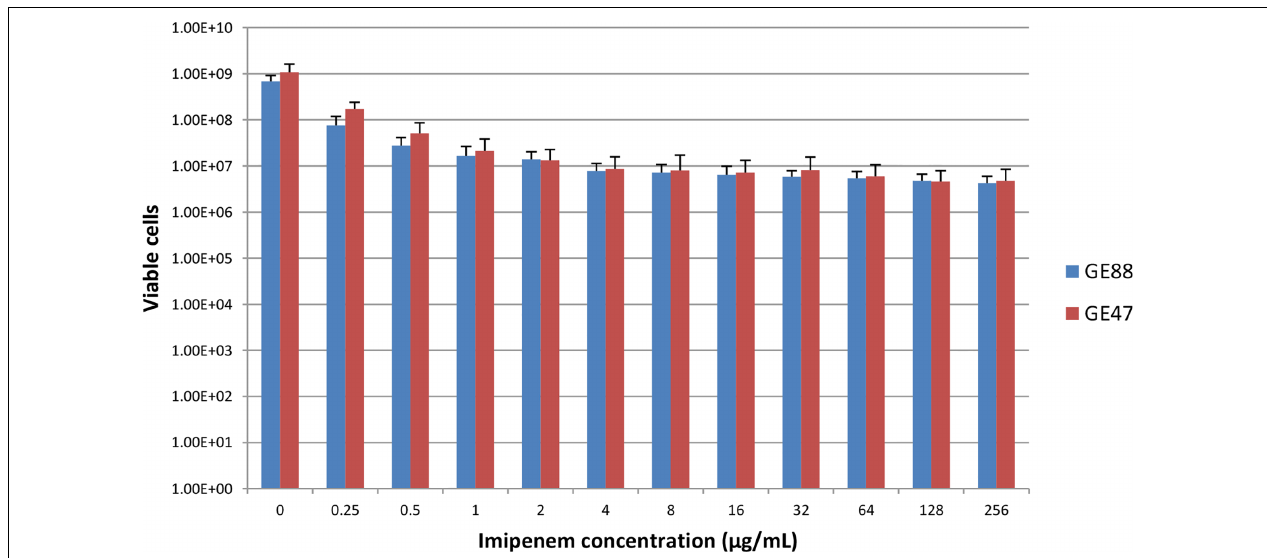
Table S2. Finally, the two strains were isolated from the sputum of two 75 year-old